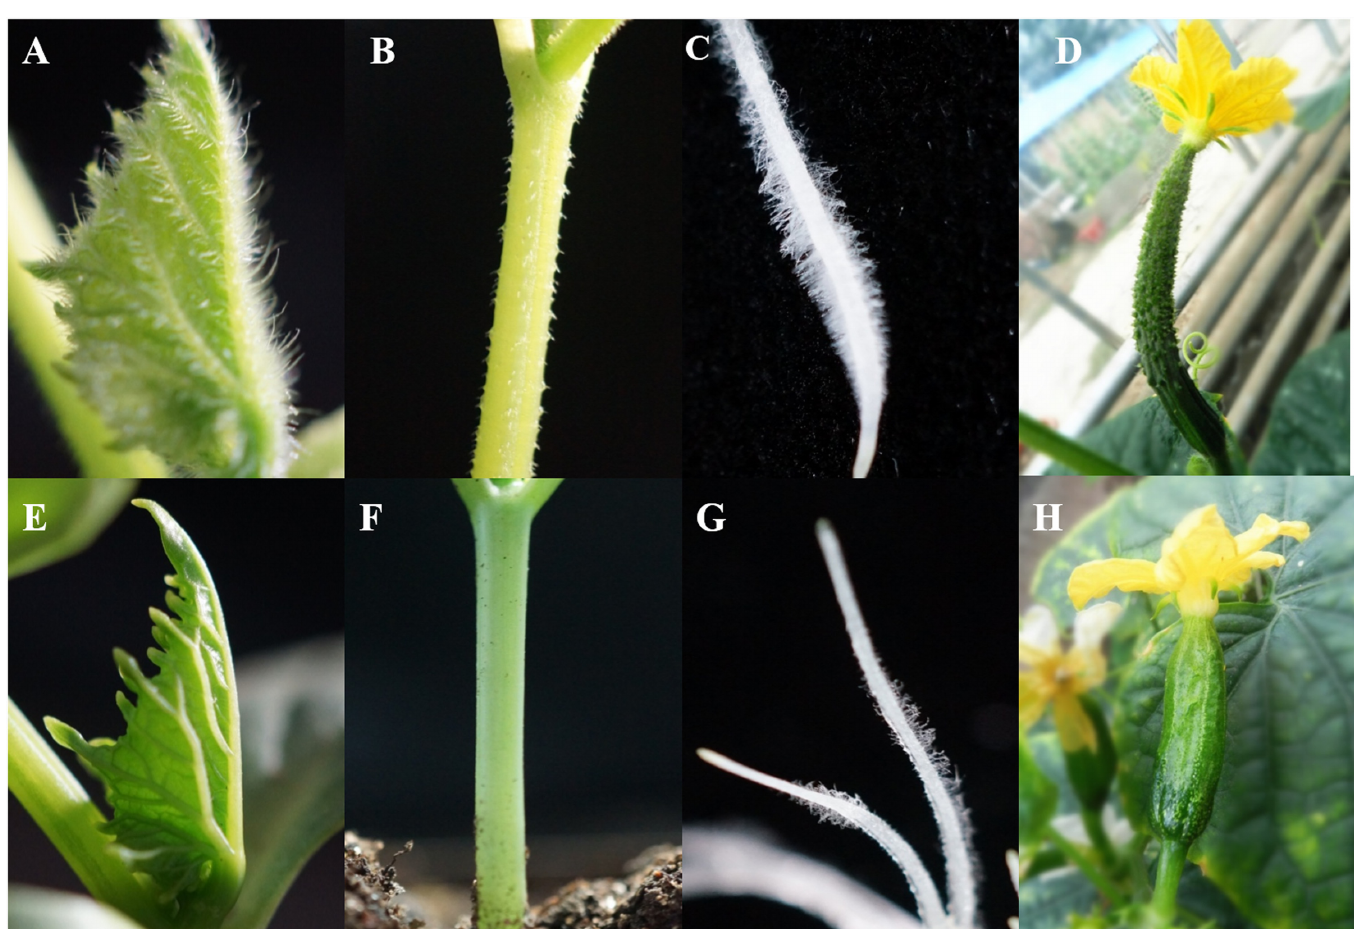
Fig 1. Morphological characterization of leaf, stem, root, fruit in 9930 and NCG157. Leaf, stem, root, fruit of 9930 (A-D). Leaf, stem, root, fruit of NCG157